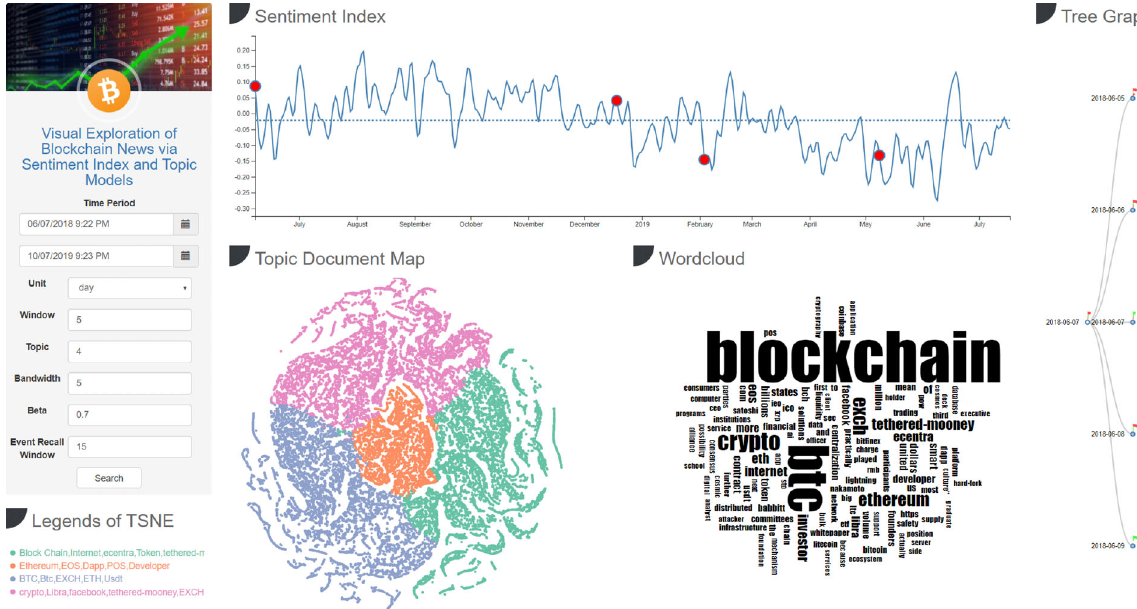
Fig. 2 Visualization system overview. Our system has five main parts: a sentiment curve view, a tree visualization view, a wordcloud view, a topic document map, and an LDAVIS view on the LDA